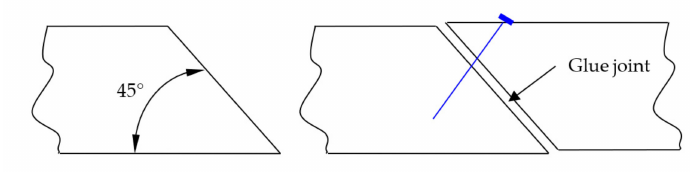
Figure 1. The binding system proposed in this